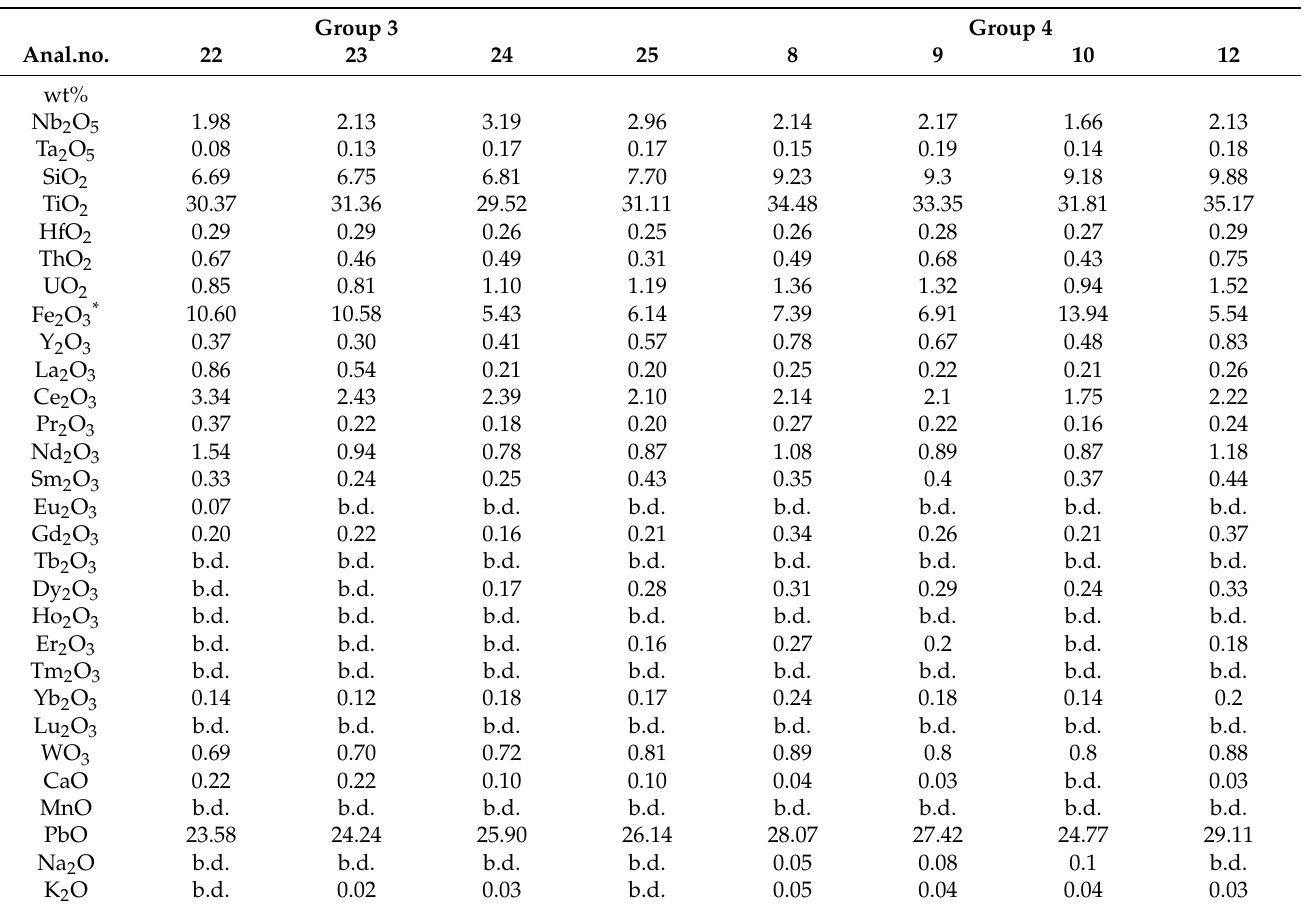
Table 2. Compositions of Pb-Ti-Fe-Si